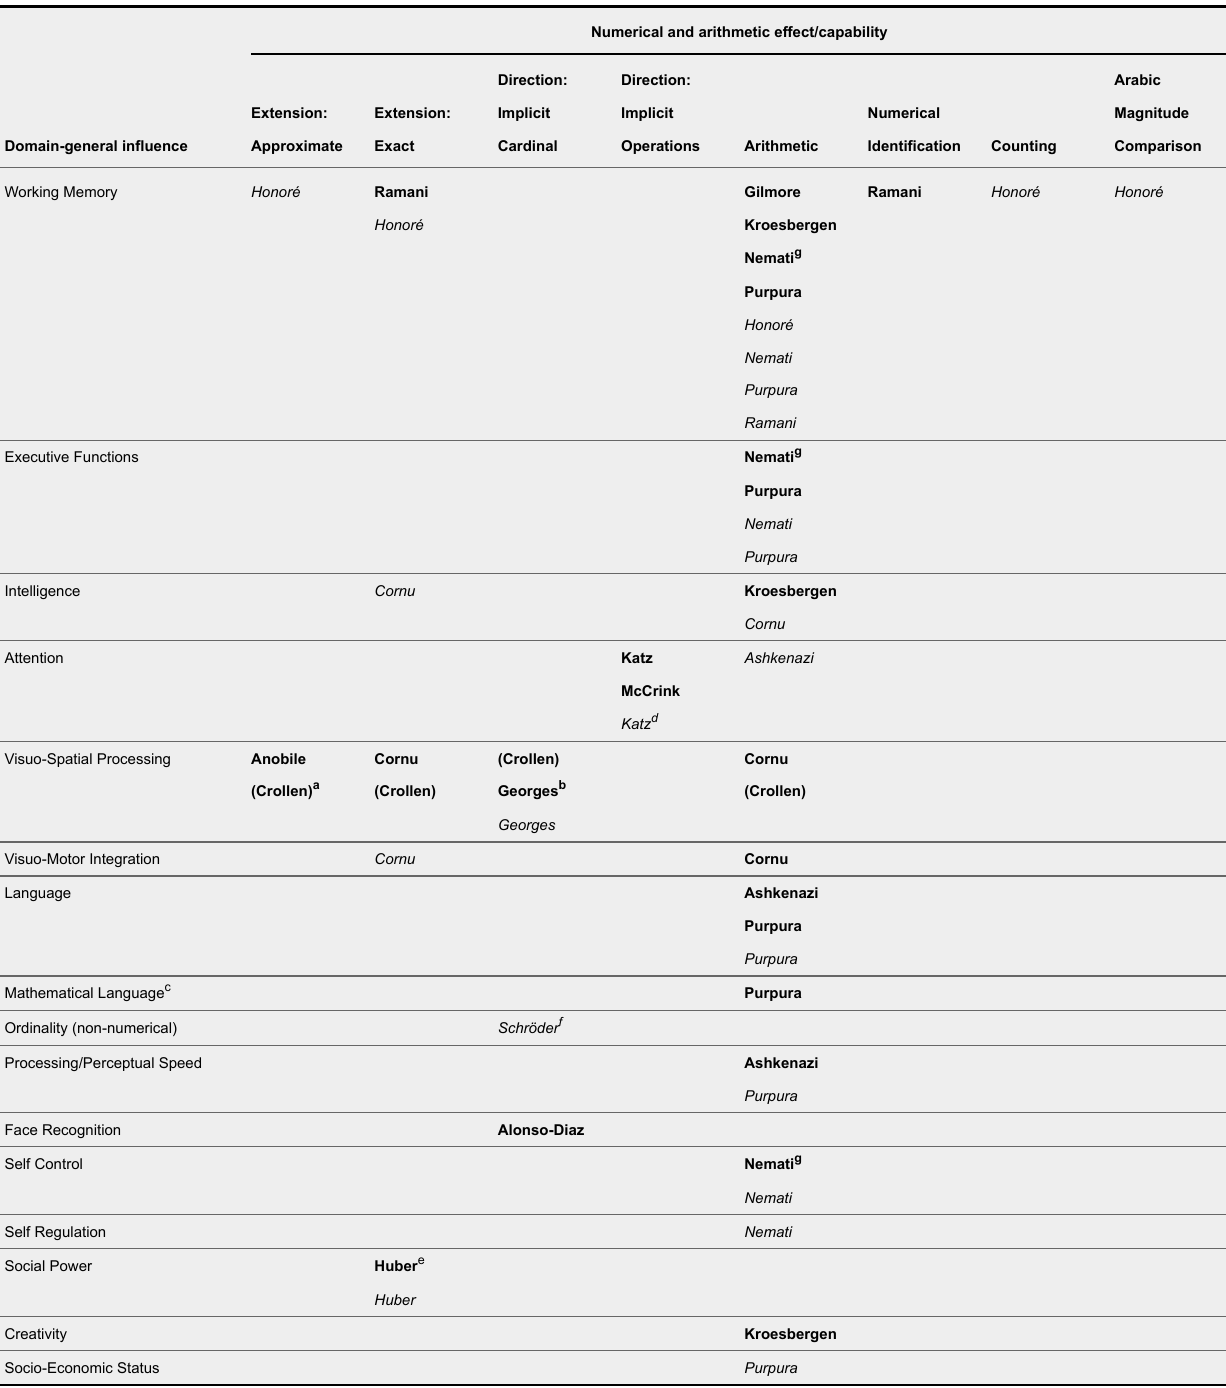
Domain-General Influences on Numerical Processing and Arithmetic Reported in the Studies in This Special Issue